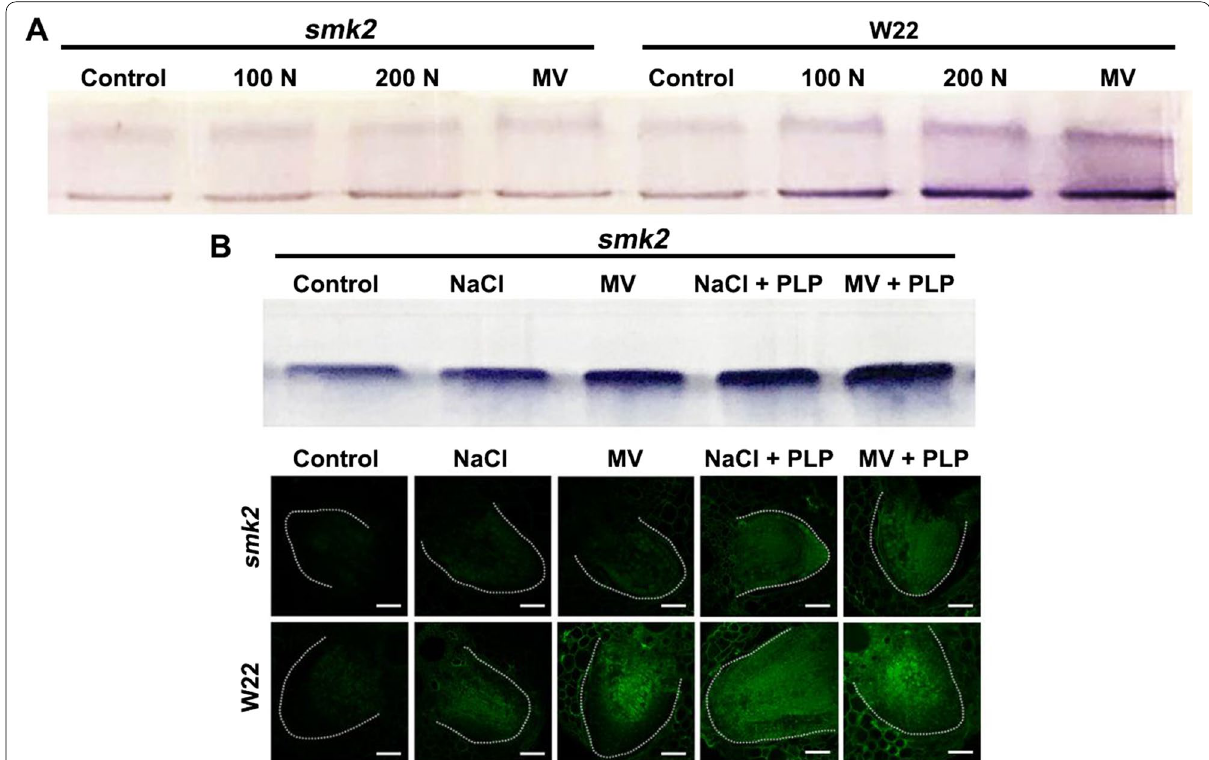
Fig. 6 PLP was essential for AAO activity. A AAO activity of smk2 heterozygous and W22. 6-d-old maize seedlings were treated with 100 mM NaCl (N), 200 mM NaCl and 10 μM MV (methyl viologen) for 24 h. The maize seedlings roots were harvested for detection of AAO activity. B AAO activity of smk2 heterozygous. 6-d-old maize seedlings were treated with H 2 O (Control), 200 mM NaCl (N), 10 μM MV (methyl viologen), 200 mM NaCl 100 μM PLP and 10 μM MV 100 μM PLP for 24 h. The maize seedlings roots were harvested for detection of AAO activity. C ABA detection in smk2 + + heterozygous and W22 maize LRs. 6-d-old smk2 heterozygotes and W22 subjected to H 2 O (Control), 200 mM NaCl (N), 10 μM MV (Methyl